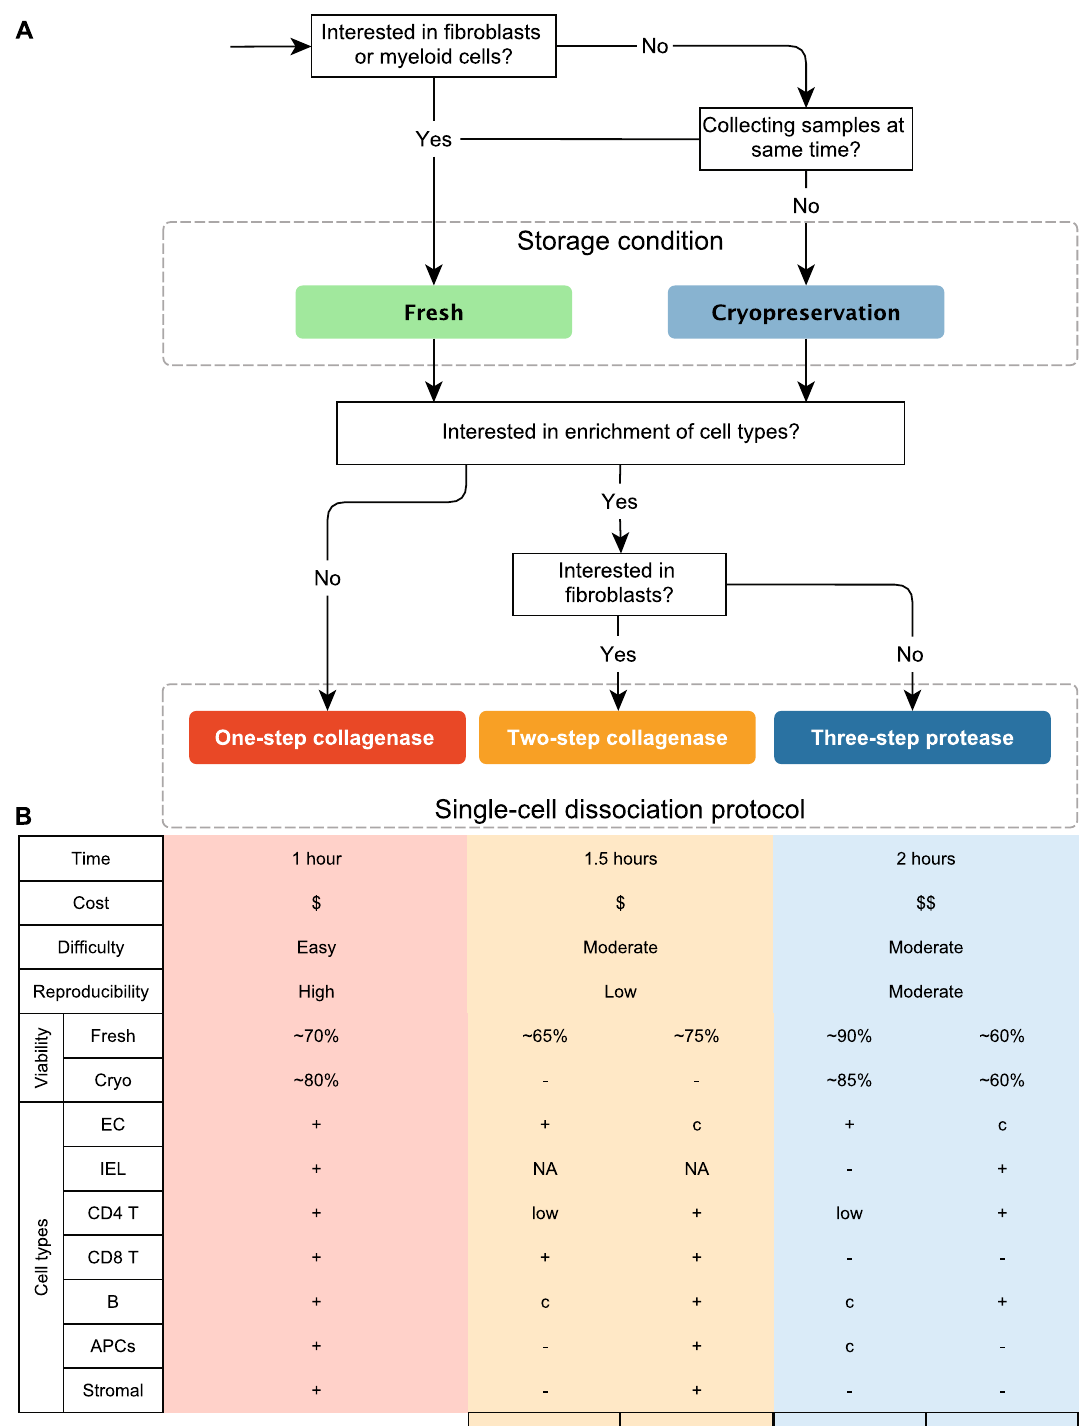
Figure 5. Decision tree for single-cell dissociation of gut tissue for scRNA-seq. ( A ) Flow-chart designed to assist researchers in choosing a dissociation protocol for gut tissue based on their specific needs. ( B ) Overview of the main differences between the protocols. IEL, intraepithelial cell; EC, epithelial cell; EL, epithelial layer; LP, lamina propria; F1, fraction 1; F2, fraction